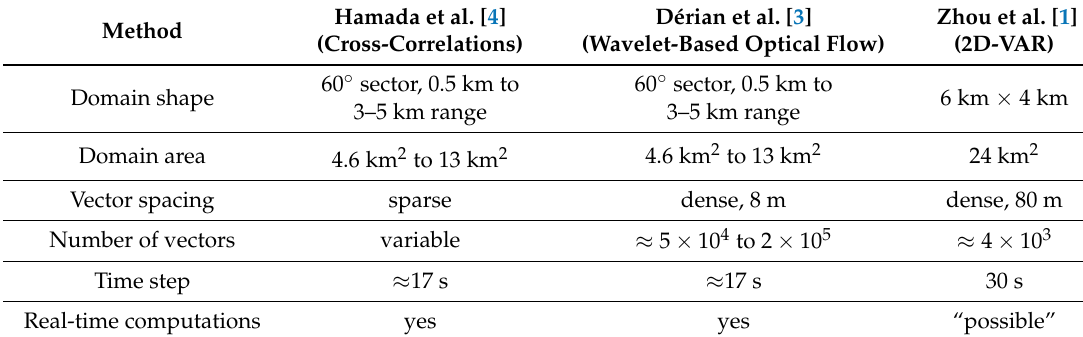
Table 1. Characteristics of 2D-2C wind field retrieval